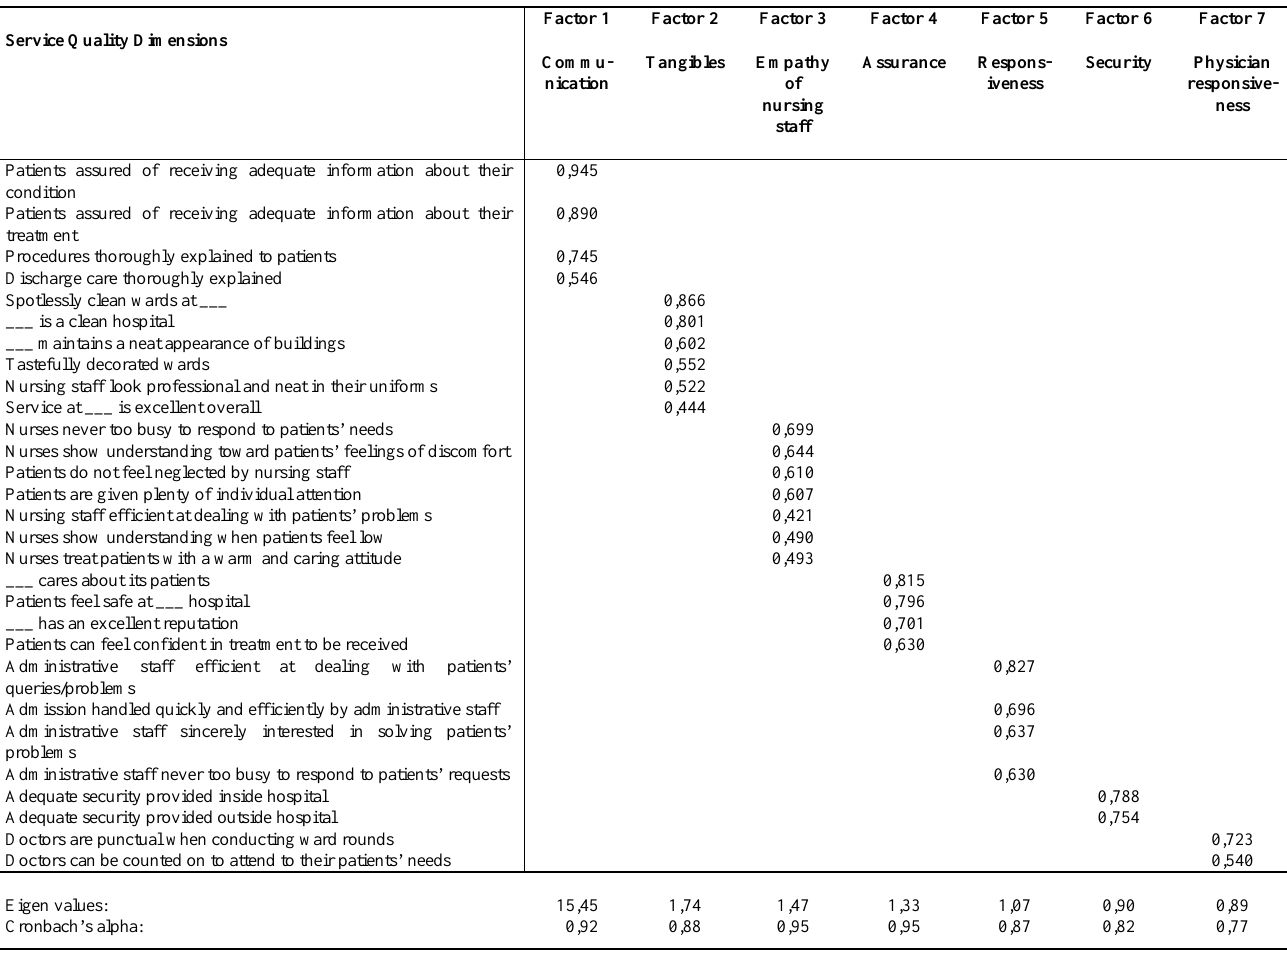
Table 1: Exploratory factor analysis results rix for service quality items